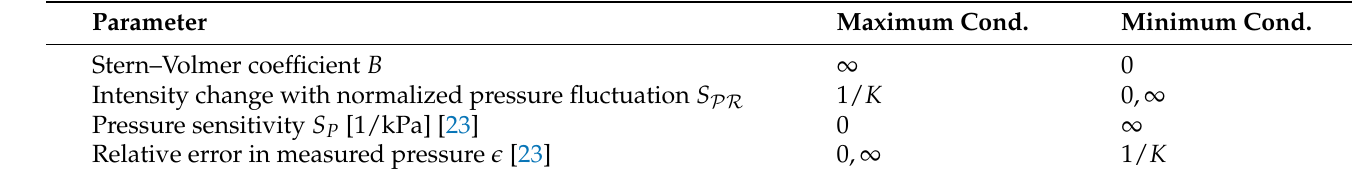
Table 1. Optimal ambient pressure for each parameter in the linear model.